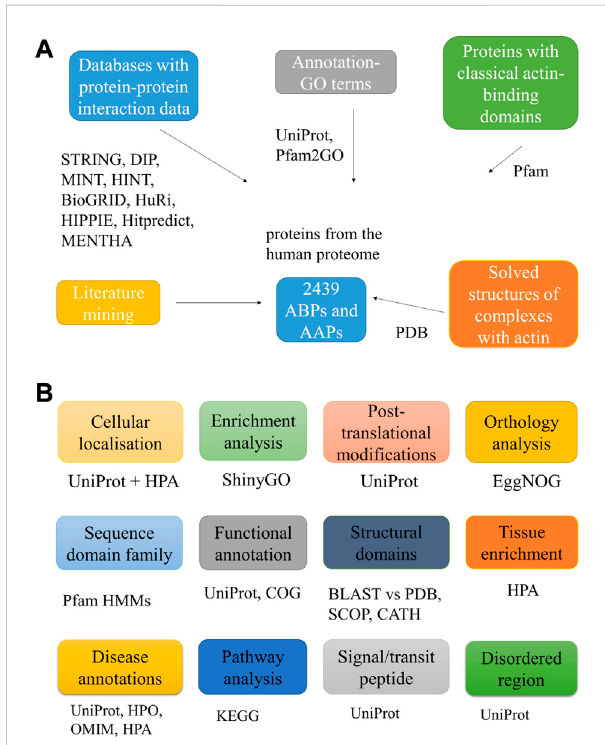
FIGURE 1 Work fl ow used to mine putative AAPs. The fi gure lists the different approaches used to identify the AAPs (A) . It also lists the various downstream analyses carried out for the proteins with the tools, databases, and web servers used for the same (B)